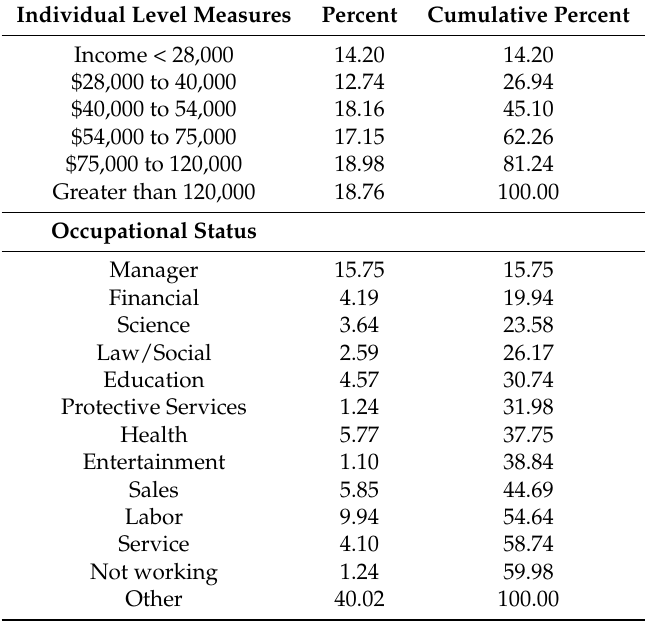
Table 1. Distribution of policy holders by income and occupational status.